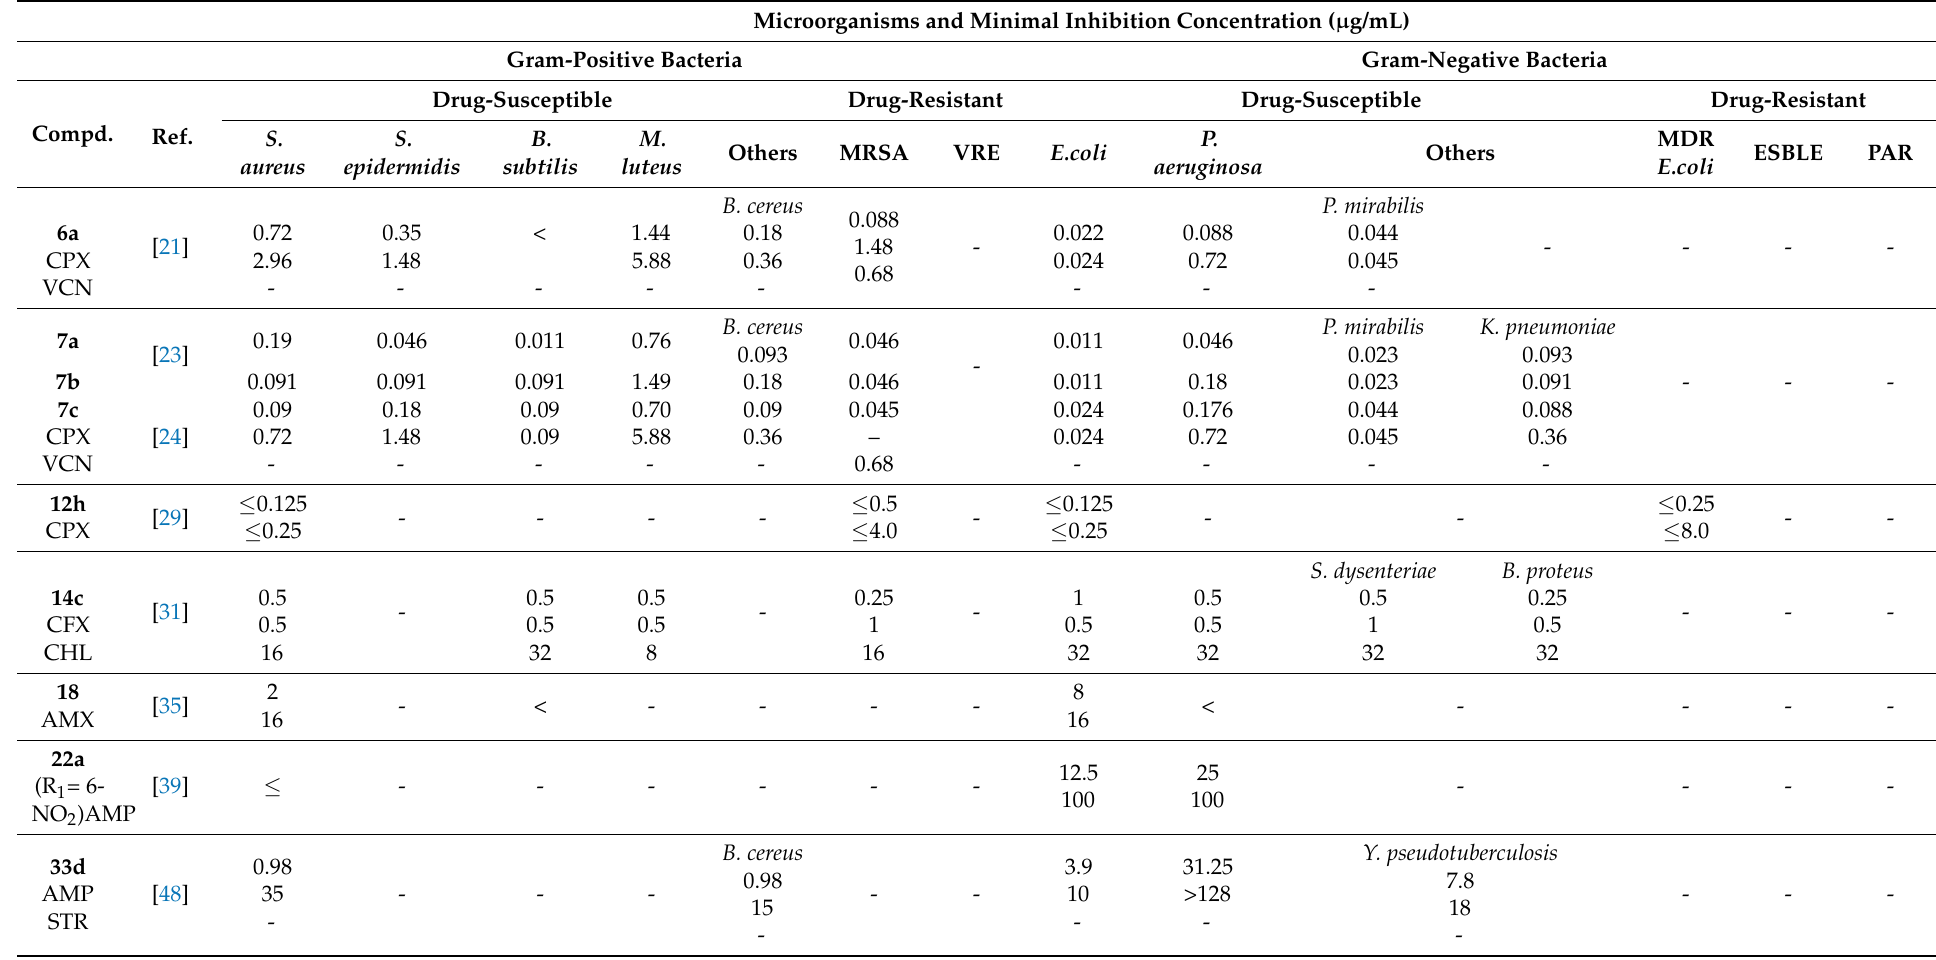
Table 1. 1,2,4-triazole derivatives with the most potent antibacterial